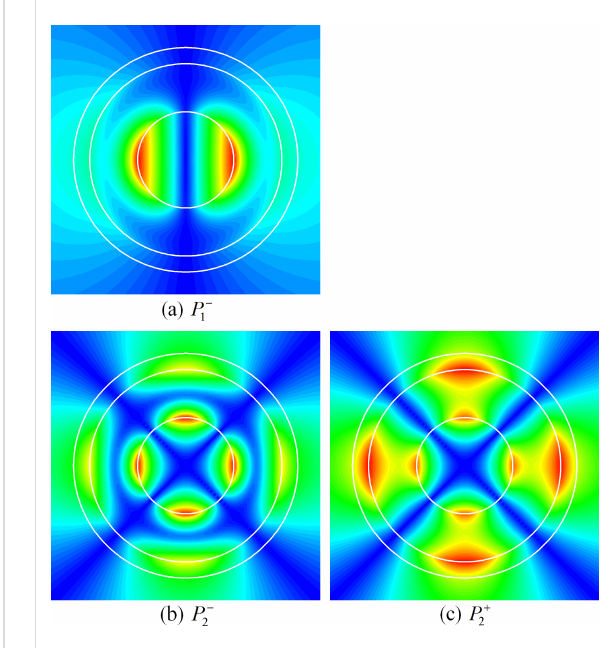
Figure 4: Near H-fields of the eigenmodes of thick-tube nanolaser, a = 30 nm, d = 10 nm, and h = 30 nm: (a) λ = 419.485 nm, γ = 0.137, (b) λ = 386.768 nm, γ = 0.1, (c) λ = 349.074 nm, γ =